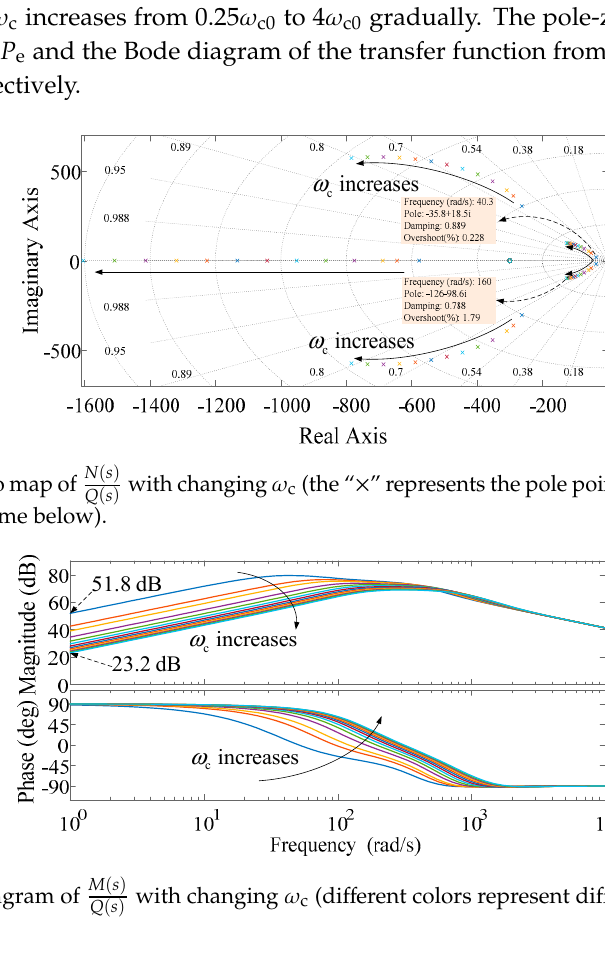
w (different colors represent different gains; the